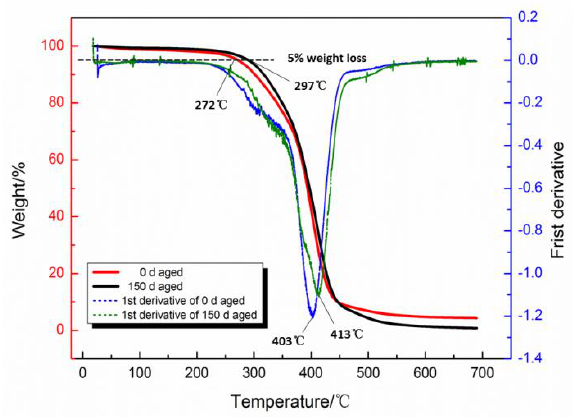
Figure 10. TG and DTG curves for polyurea before and after aging.